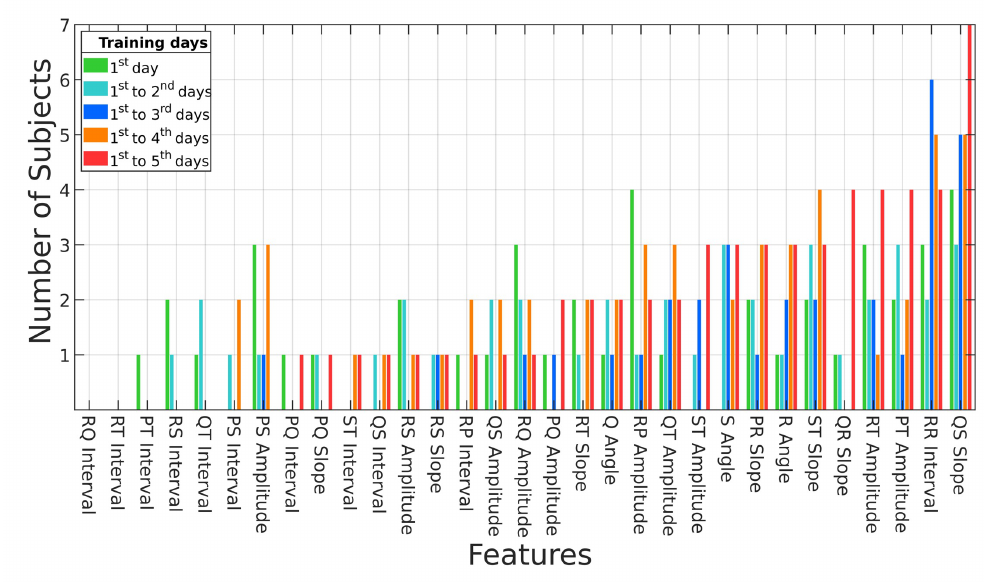
Figure 8. Feature selection results based on optimized